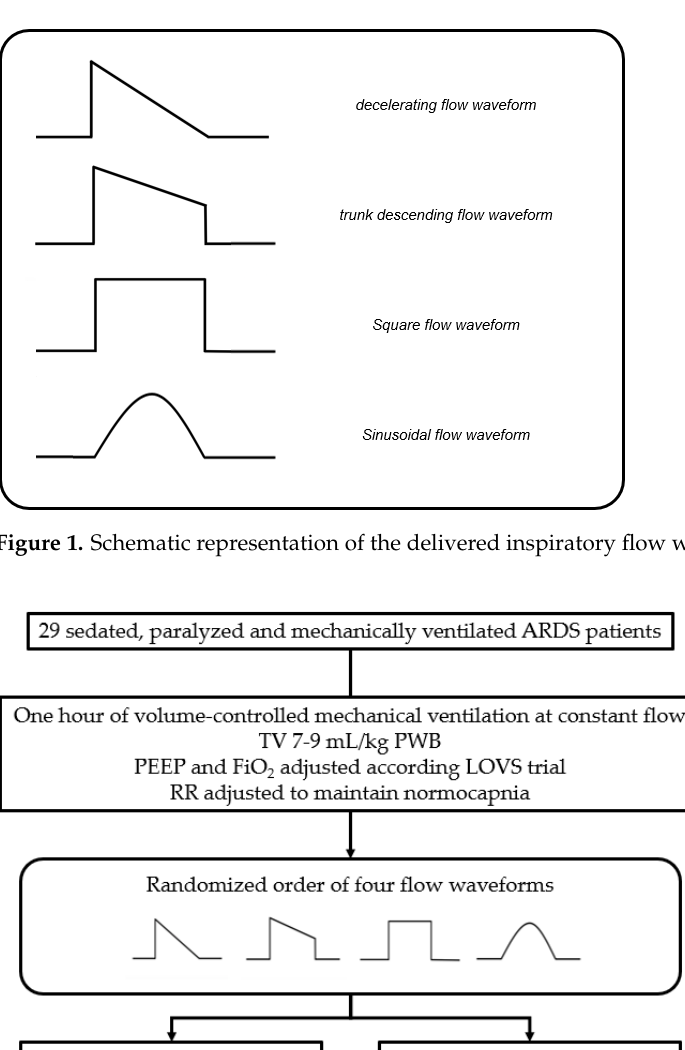
Figure 2. Study flow-chart.